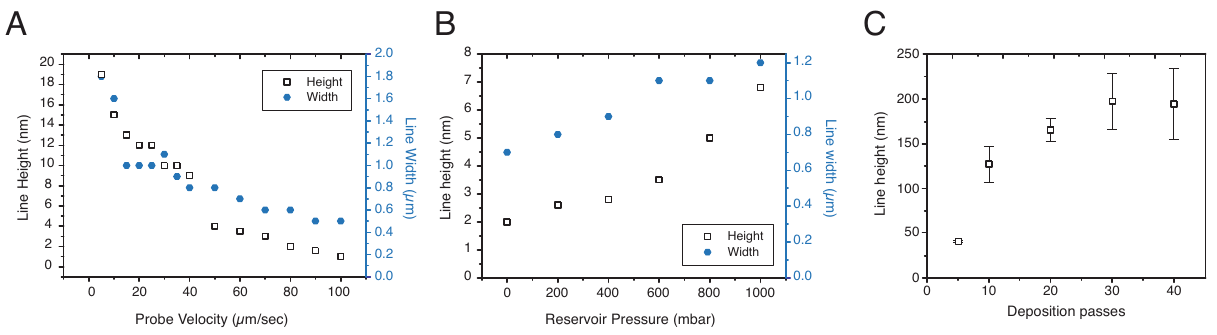
Fig. 3 Data showing the in fl uence of various printing parameters on the dimensions of the fi nal printed lines. A A plot showing the changes in the dimension of polymer lines with increasing printing speed, at 200 mbar. B A plot showing the variation of the dimension of polymer lines with increasing reservoir pressure, at the constant speed of 10 µ m/sec. C Height of printed lines constructed after a designed number of passes and rinsing with a good solvent, error bars are st. dev. (where n =